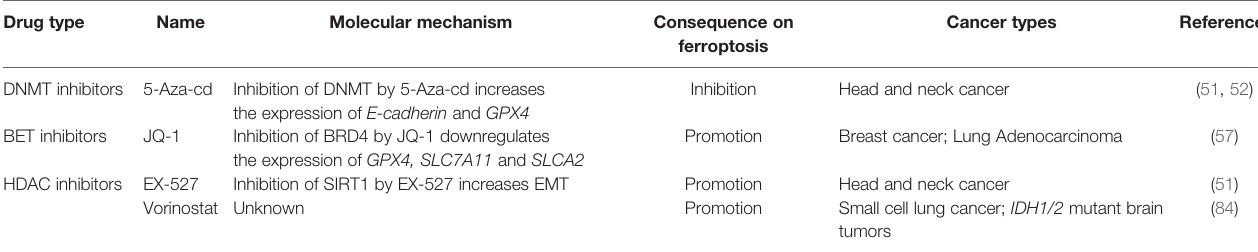
TABLE 2 | Epigenetic drugs that modulate ferroptosis in cancer